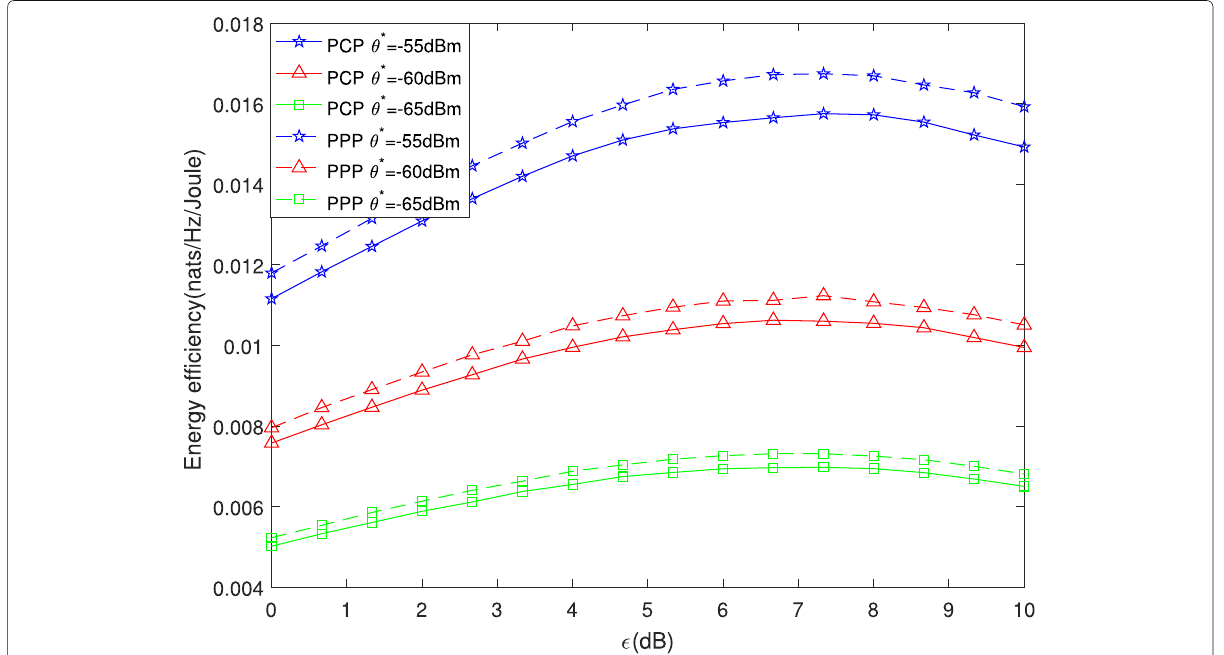
Fig. 9 The simulation results of the energy efficiency based on RE with the cooperative bias factors